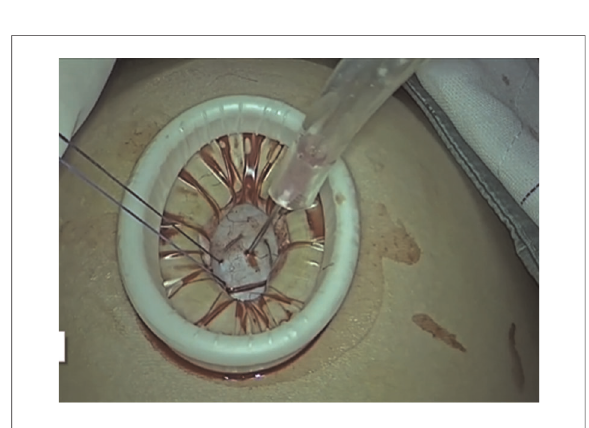
FIGURE 3 A purse-string stitch was placed around the opening to prevent spillage and the needle was inserted to suck out most of the cystic fl